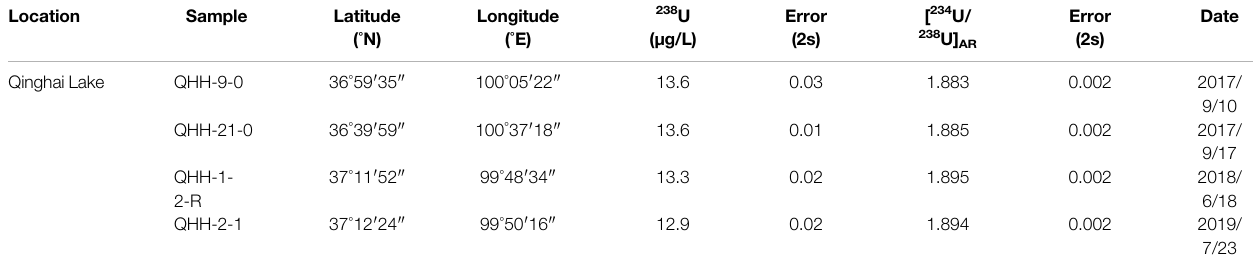
TABLE 7 | U isotope data from samples collected from Qinghai Lake in different years.